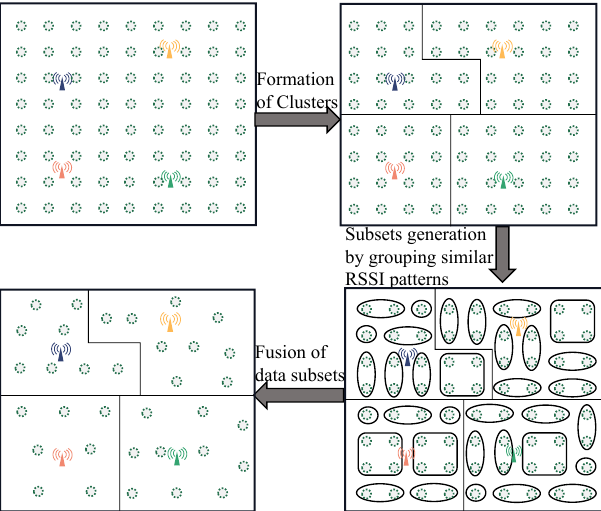
Figure 2. The working process of proposed efficient clustering